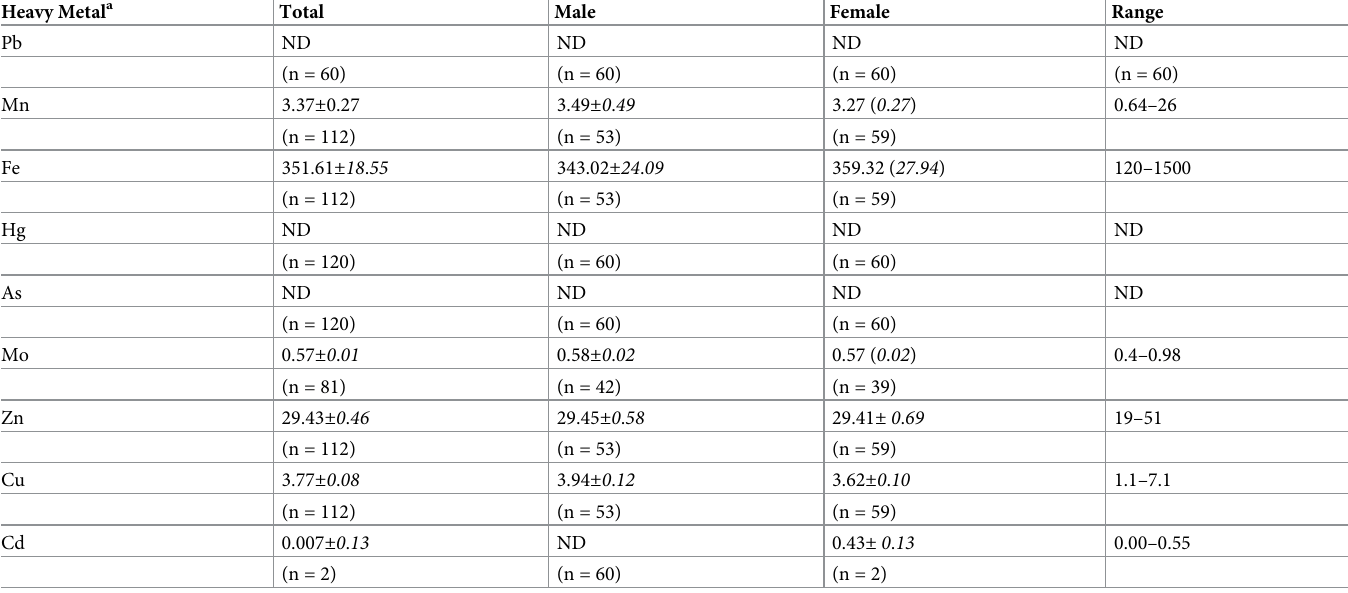
Table 4. Mean ( ± SE ) liver concentrations (ppm, wet weight) for heavy metals in both male and female muskrats ( Ondatra zibethicus ) in Pennsylvania, USA, 2018– 2019. Heavy Metal a